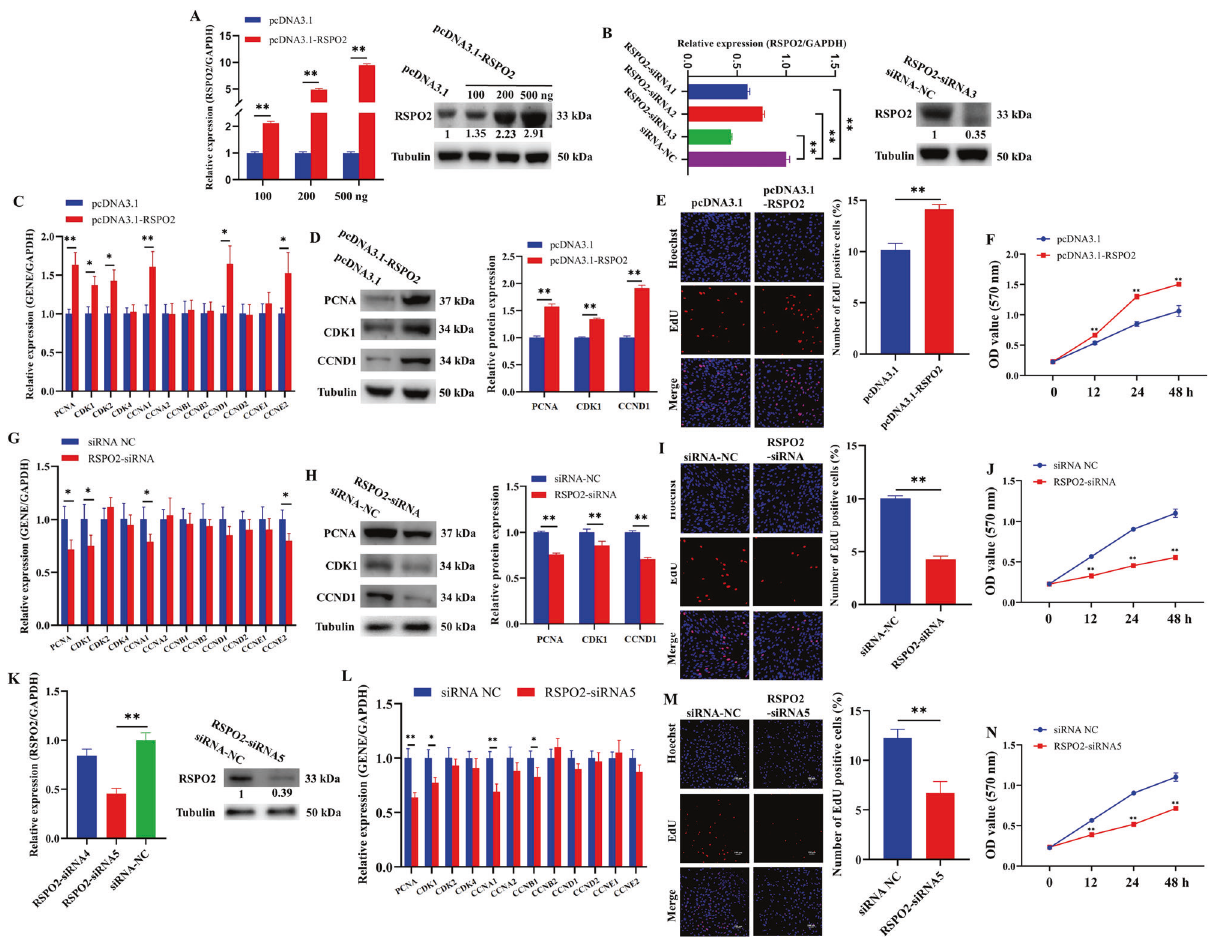
Fig. 2 RSPO2 promoted the proliferation of porcine ovarian GCs. A , B The mRNA and protein expression levels of RSPO2 after transfection with pcDNA3.1- RSPO2 ( A ) or RSPO2 -siRNA ( B ) in porcine GCs. The numbers below bands were folds of band intensities relative to control. The band intensities were measured by ImageJ and normalized to Tubulin. C , D The mRNA ( C ) and protein ( D ) expression levels of PCNA , CDK1 , and CCND1 in porcine GCs with RSPO2 overexpression. E , F The proliferation rates of GCs with RSPO2 overexpression were assessed by EdU ( E ) and MTT assay ( F ). G , H The mRNA ( G ) and protein ( H ) expression levels of PCNA , CDK1 , and CCND1 in porcine GCs with RSPO2 knockdown. I , J The proliferation rates of GCs with RSPO2 knockdown were assessed by EdU ( I ) and MTT assay ( J ). K The mRNA and protein expression levels of RSPO2 after transfection with another two RSPO2 -siRNAs ( RSPO2 -siRNA4 and 5) in porcine GCs. L The mRNA expression levels of cell cycle- related genes in porcine GCs transfected with RSPO2 -siRNA5. M , N The proliferation rates of GCs transfected with RSPO2 -siRNA5 was assessed by EdU ( M ) and MTT assay ( N ). * P < 0.05, ** P <